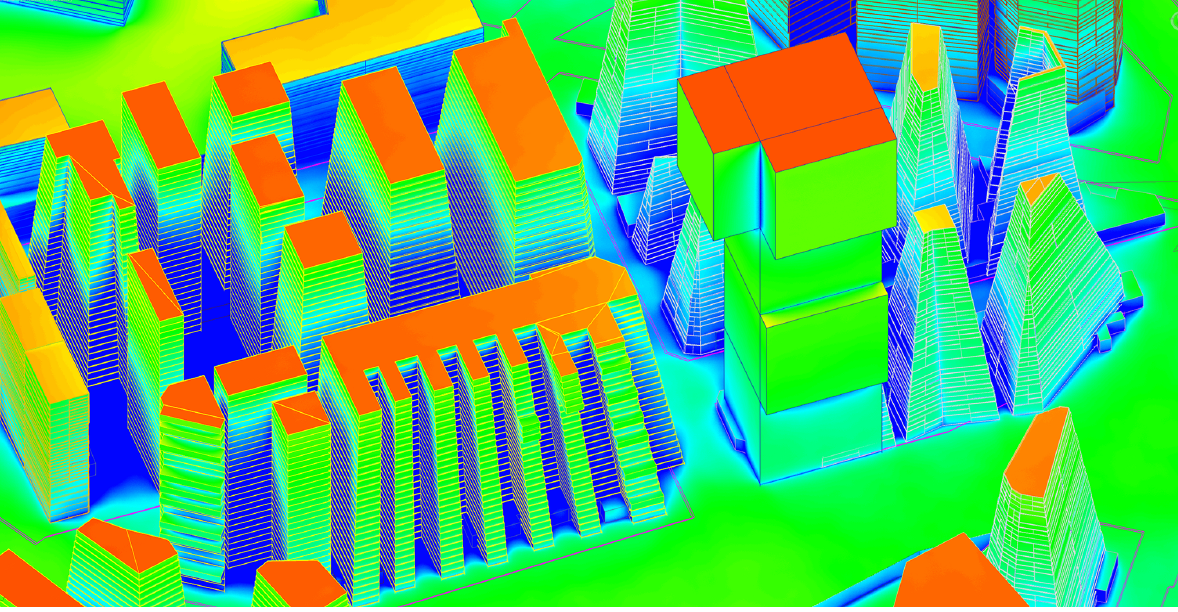
Figure 16. This figure shows a screen grab illustrating the detailed 3D SVF calculation on potential urban form with tapering setback profiles, as well as more complex cantilevered balconies and building masses. The SVF is not only calculated at the ground level, but also across building façades (potentially useful for assessing view quality within